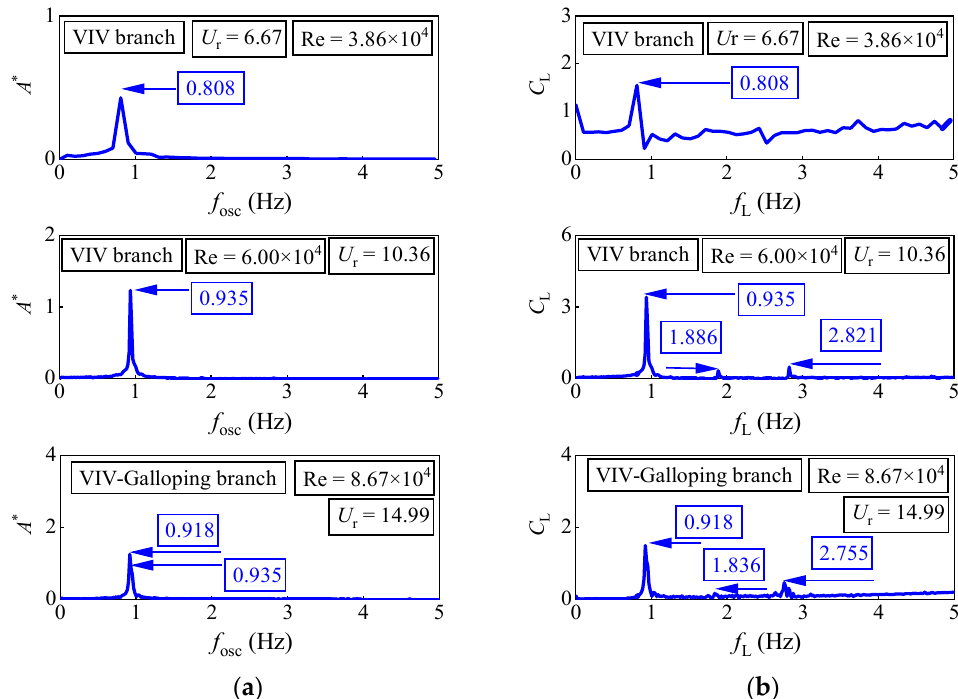
Figure 13. Spectral of Cir-T-Att with D = 0.08 m, R e = 3.86 × 10 4 ~9.21 × 10 4 . ( a ) Displacement spectral. ( b ) Fluid force spectral.